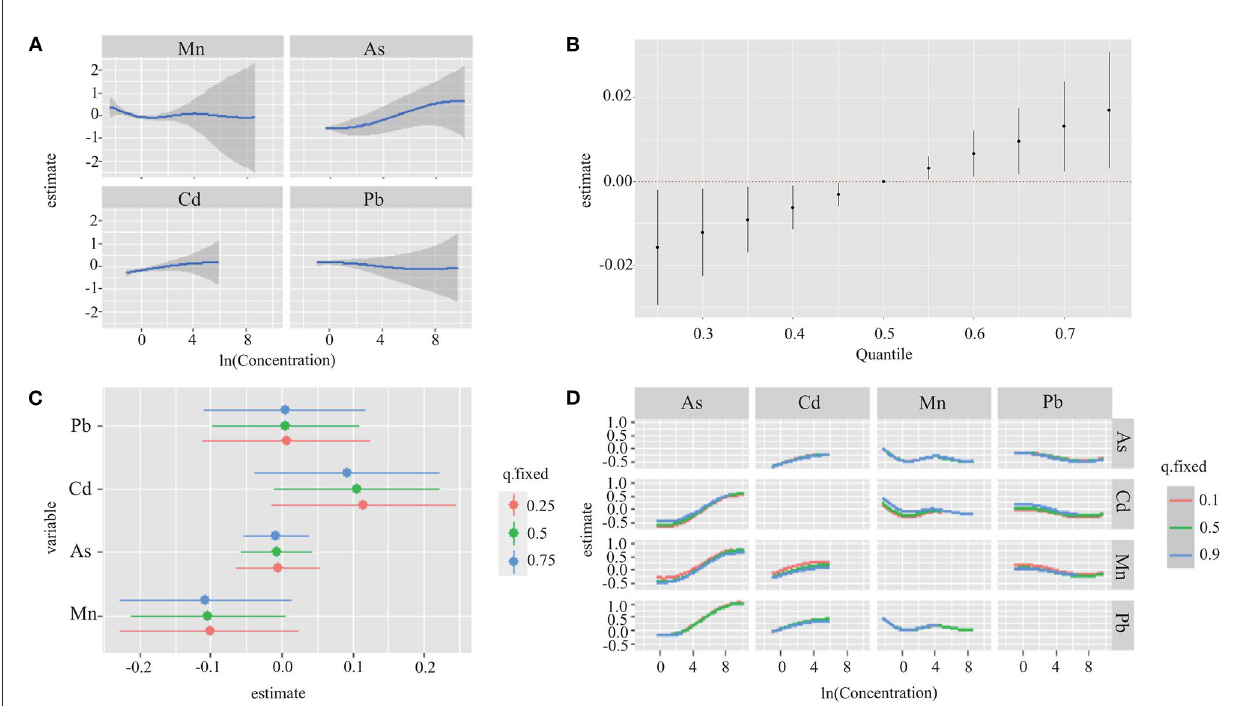
FIGURE2 Joint effect of the four metals (Mn, As, Cd, and Pb) on hypertension risk by using BKMR model. The results were adjusted for age, sex, region, education level, drinking status, smoking status, family history of hypertension, antihypertensive use, BMI, TC, TG, and FBG. (A) Univariate exposure-response functions and 95% CI for association between single metal exposure when other metals exposure are fixed at the median. (B) Overall effect of the mixture estimates and 95% CI. (C) Single metal association (estimate and 95% CIs). This plot compares hypertension risk when a single metal was at the 75th vs. 25th percentile, when all the other metals were fixed at either the 25th, 50th, or 75th percentile. (D) Bivariate exposure response functions for each of the metal presented on the right longitudinal axis when the other metal presented on the upper coordinate axis holding at different quantiles (25th, 50th, and 75th) and other two metals were held at the